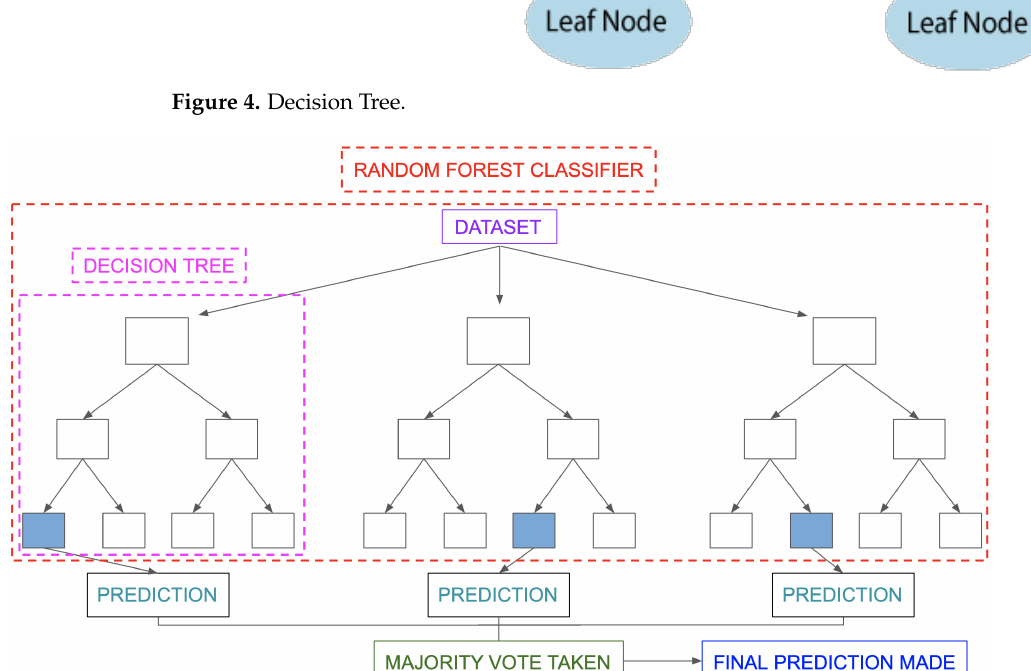
Figure 4. Decision Tree.